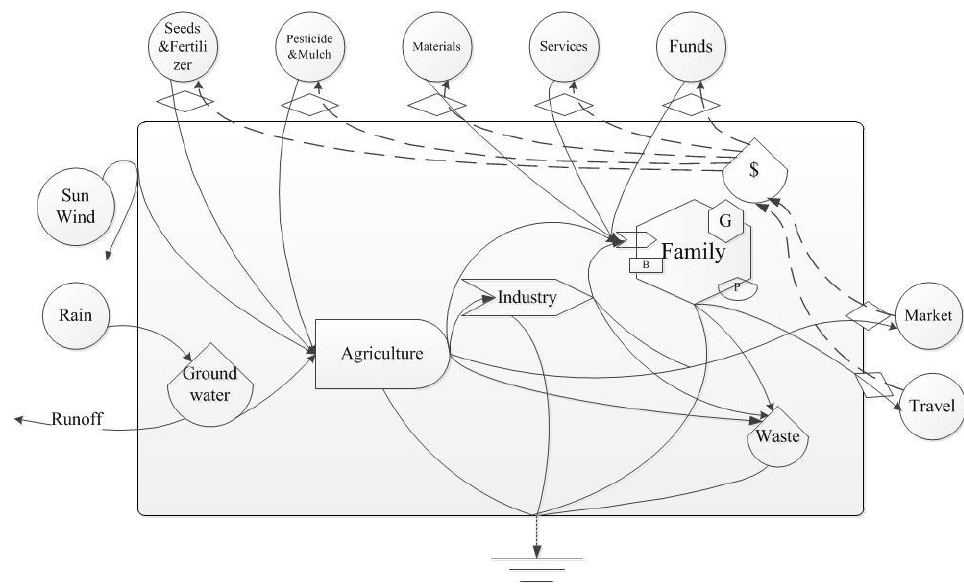
Figure 1. Emergy flows of a rural ecosystem. Note: B, business; P, people; G, government; $, dollar. Emergy indices of rural ecosystem are shown in Table 1. System emergy flows repre- sented the basic metabolic process in the rural system. Social subsystem indicators (ED, Ucap, Ucap 1 , Ucap 2 , Ucap 3 ) indicated per unit area emergy consumption and per